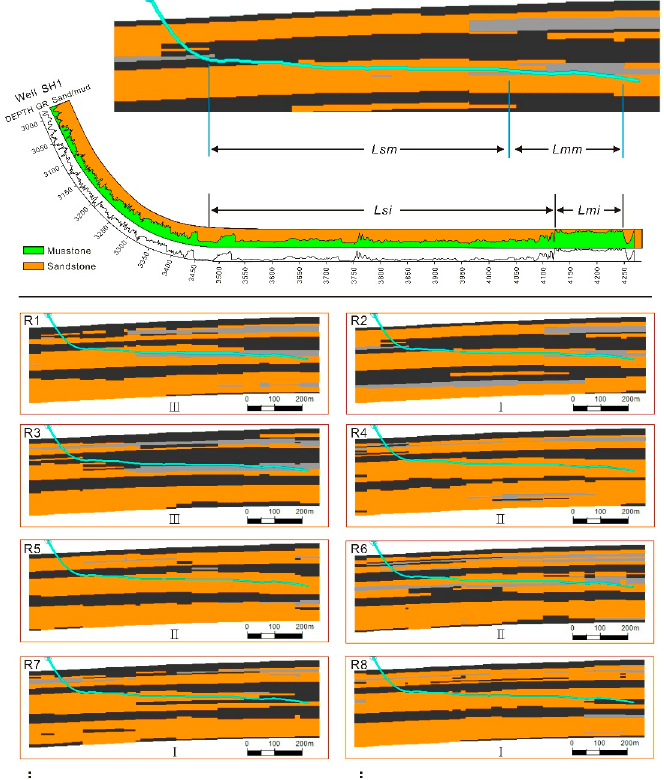
Figure 11. Classified cross-sections of prediction models for horizontal well SH1. The uppermost figure is a cross-section of a simulated sandstone and mudstone model, and the lower figure next to it is the 1-D interpreted sandstone and mudstone model. The lowest cross-sections are eight stochastic realizations ( R1 , R2 , ..., R8 ) generated via the same variogram parameters, but using different seed numbers. The location of horizontal well SH1 is shown in Figure 2a. Lsm (Lmm) refers to the length of sandstone (mudstone) obtained from stochastic modeling; Lsi (Lmi) refers to the length of sandstone (mudstone) obtained from well logging interpretation.